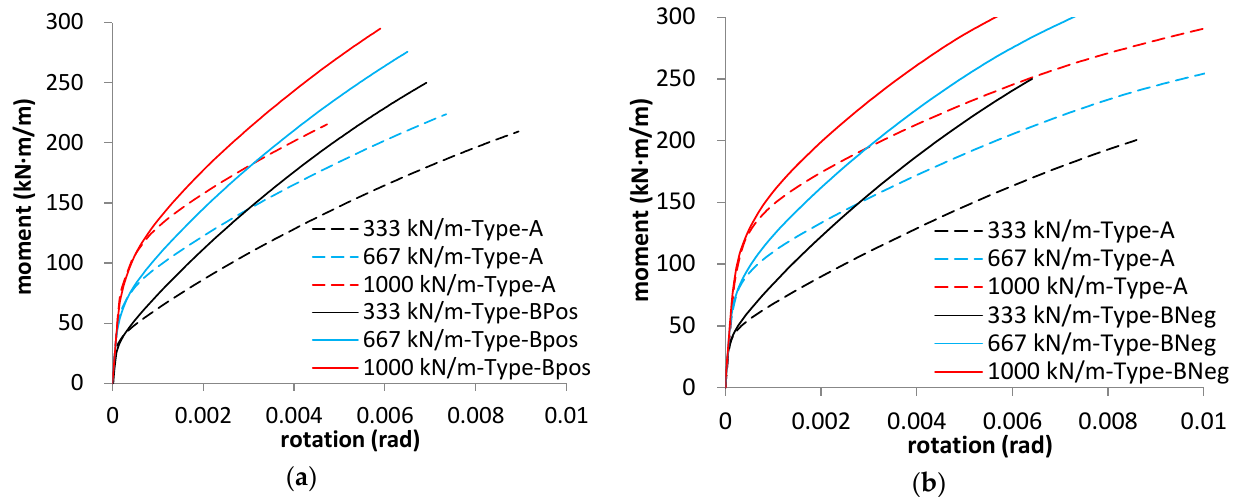
Figure 20. Evolution of the joint rotation with increasing bending moment under constant axial force: ( a ) positive cases; ( b ) negative cases.